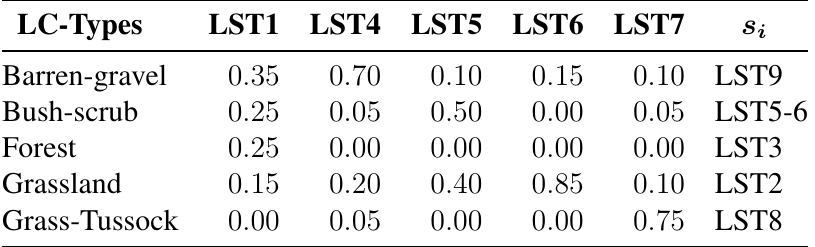
Table 2. Fractional abundance vectors ( a spectral